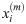
Typical behavior of the N-cell model in category (a).(A) Chemical compositions of N cells surviving at time t = 5×105. The concentration xi(m) is plotted with a color code, with the vertical axis indicating the cell index m, and the horizontal axis indicating the chemical index i, while the top band designates the composition of an “isolated” cell. Cells differentiate into two types with distinct compositions. (B) The time series of x1(m) in interacting N cells surviving at time t = 4×104, overlaid for all cells shown as different colors. Each line represents the concentration of the chemical X1 in a different cell, plotted with different colors over 100 cells. (C) The time series of the number of cell divisions per cell for interacting (red) and isolated (blue) cells. Interacting cells grow faster than isolated cells; i.e., Rμ > 1.